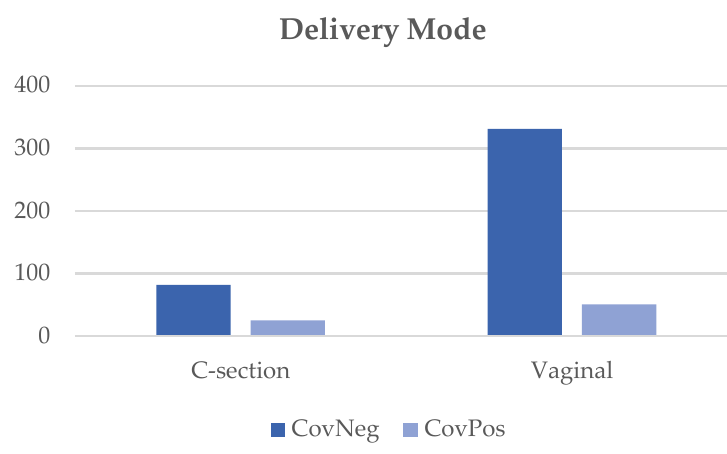
Figure 2. Mode of delivery between CovNeg and CovPos groups.